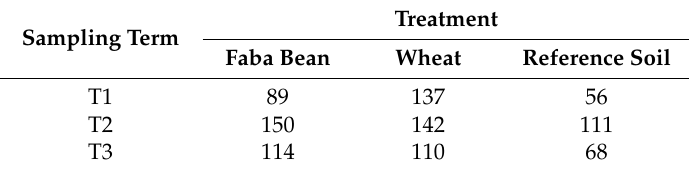
Table 3. Concentration of DNA (ng µ L − 1 ) after extraction. T1, T2, and T3 denote: two months after residue incorporation into the soil, stem elongation, and the senescence stage of the subsequent wheat crop,